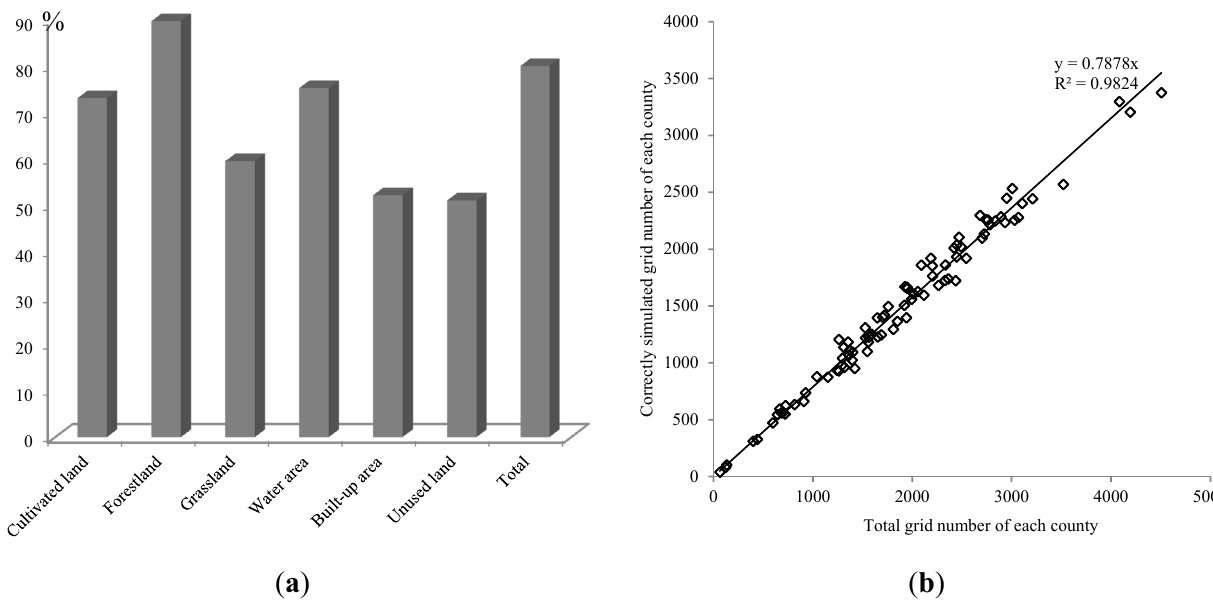
Figure 4. Accuracy verification of land use simulation: ( a ) Accuracy verification for each land use type; ( b ) accuracy verification in county